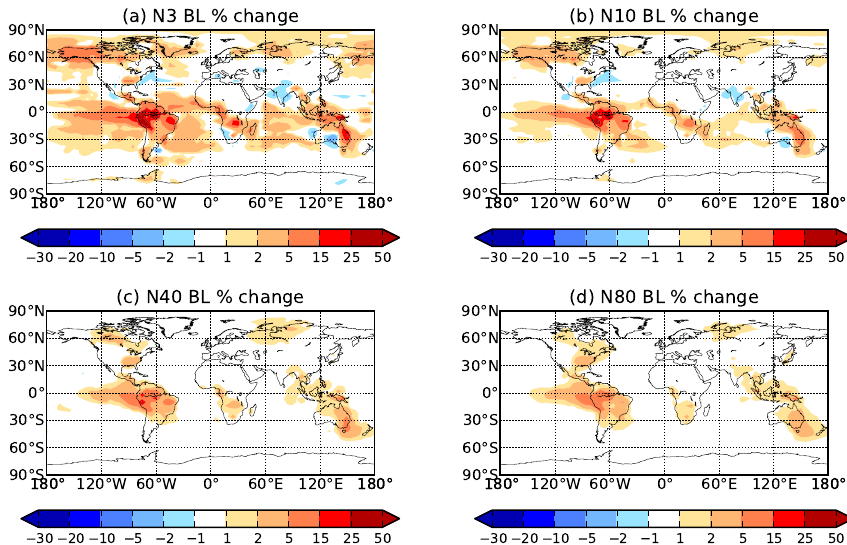
Fig. 5. The annual-mean boundary-layer change in N 3, 10, 40 and 80 due to the addition of CI+SO 2 chemistry